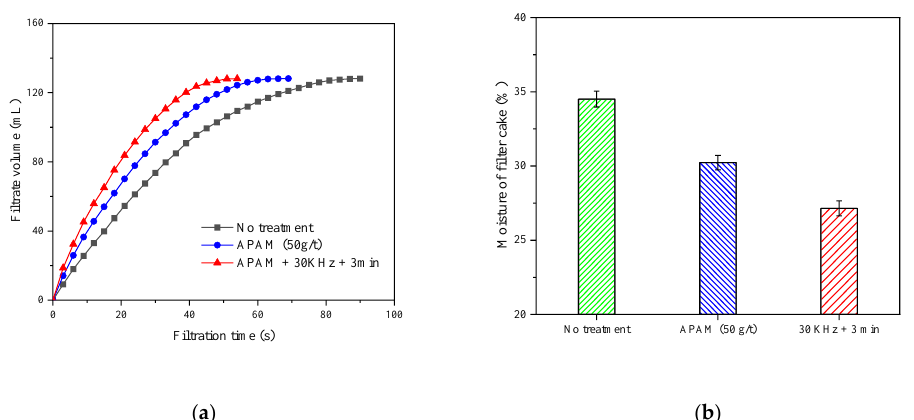
Figure 8. The filtration speed curve ( a ) and the filter cake moisture content ( b ) of different conditions.